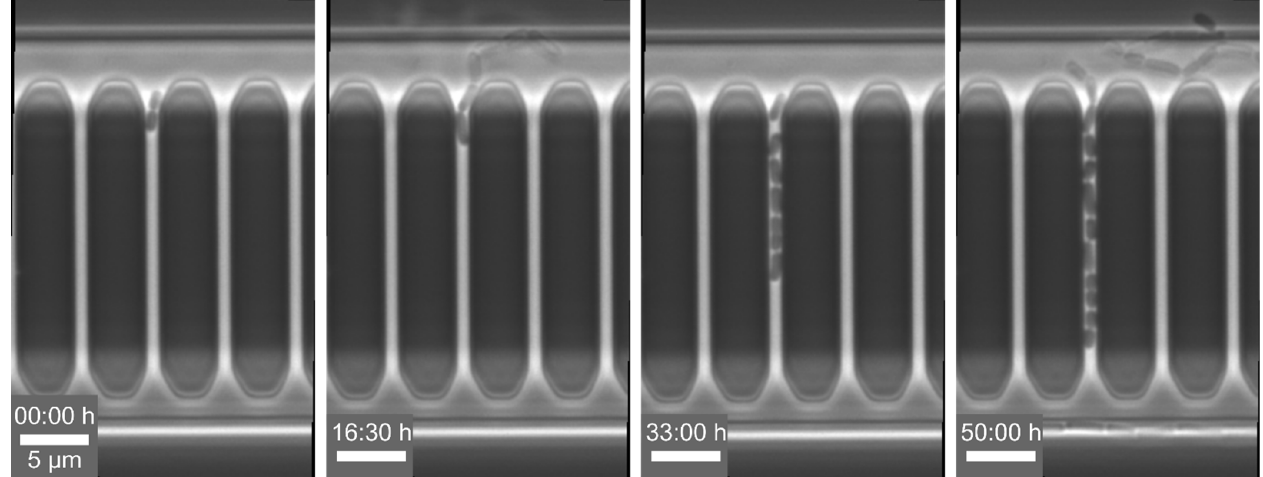
Figure 7. Microscopic images of C. glutamicum showing a prolonged division time of the cells due to the mechanical stress caused by the only 0.8 μ m wide cultivation channels (scale bar = 5 μ m).